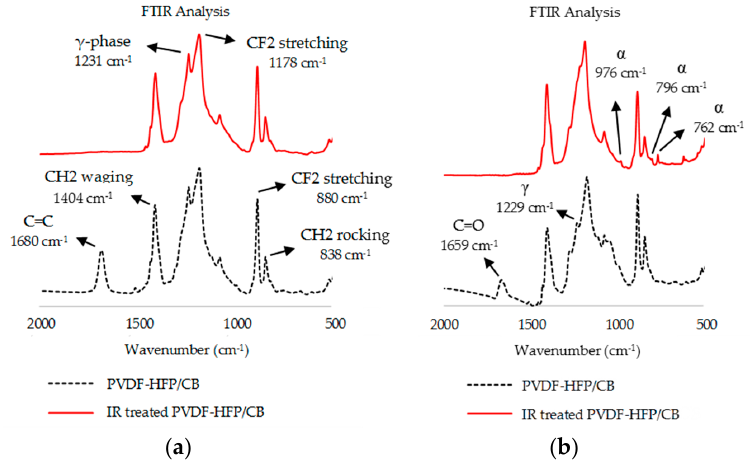
Figure 5. FTIR analysis of ( a ) PVDF-HFP (in dotted black) and IR treated PVDF-HFP (in solid red); ( b ) PVDF-HFP/CB (in dotted black) and IR treated PVDF-HFP/CB (in solid red) specifies formation of less polar alpha structures and loss of several bonds after IR treatment in presence of CB.